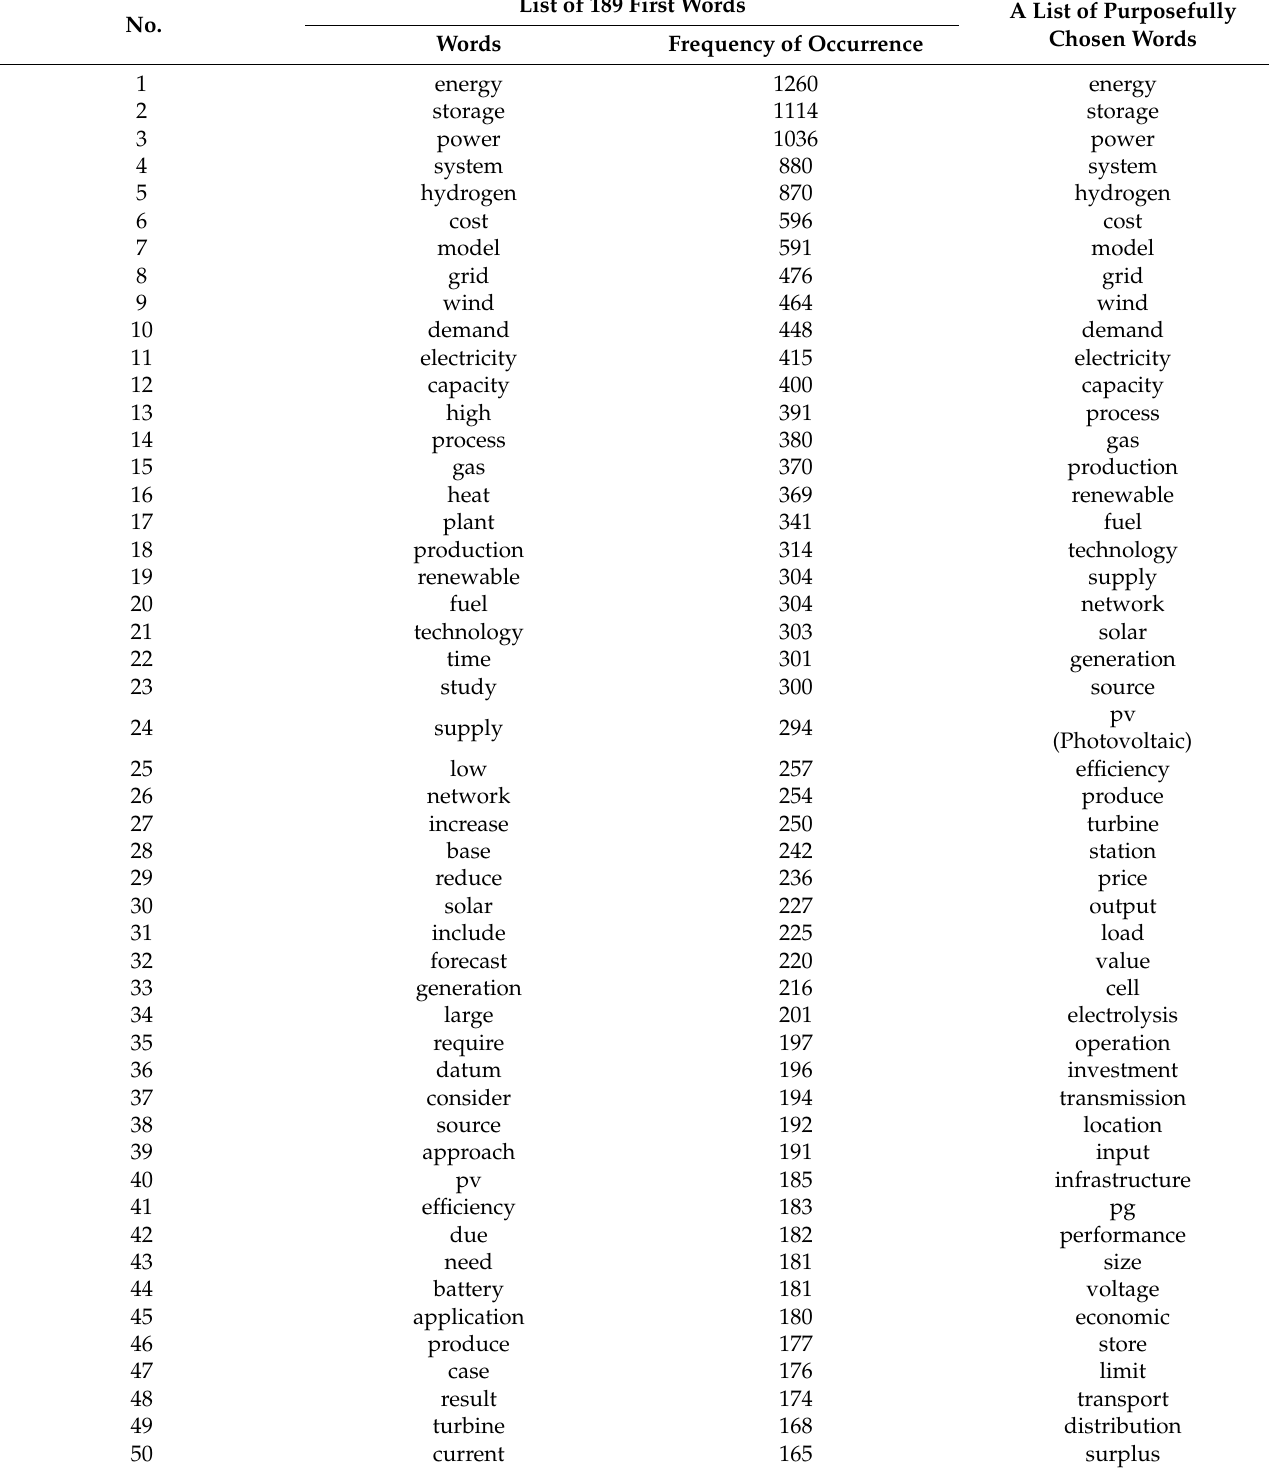
Table A2. Lists of the first and purposefully selected words used in the analysis of